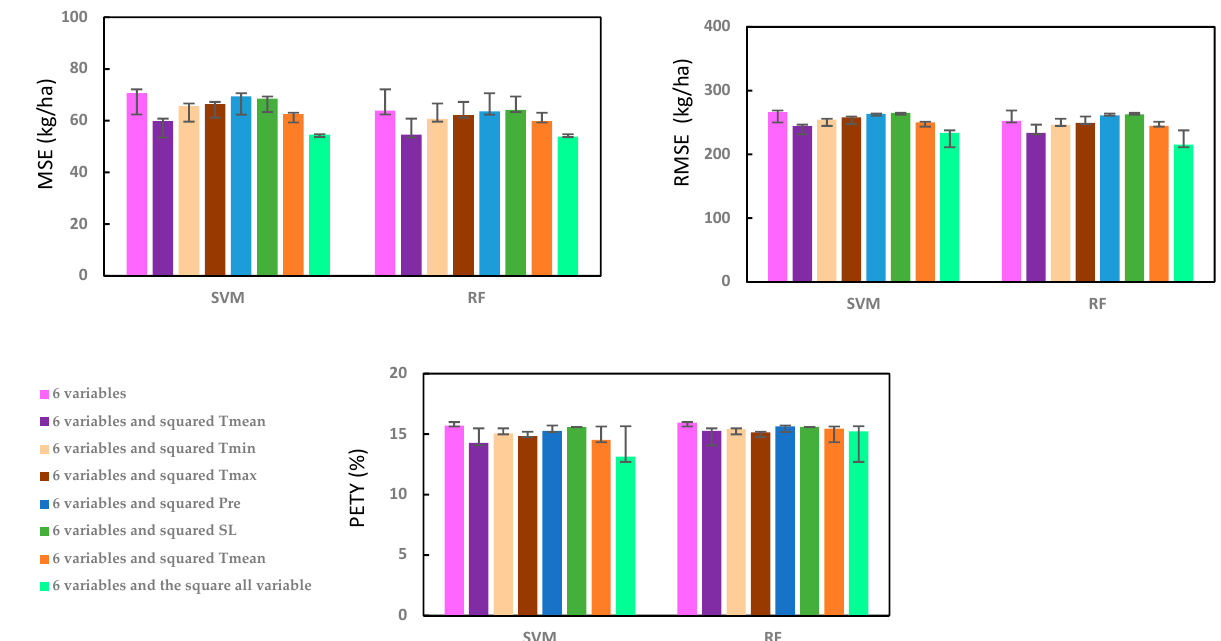
Figure 9. The mean square error, root mean square error and percentage error of the perform for tea yield prediction in growing season by including one variable input.